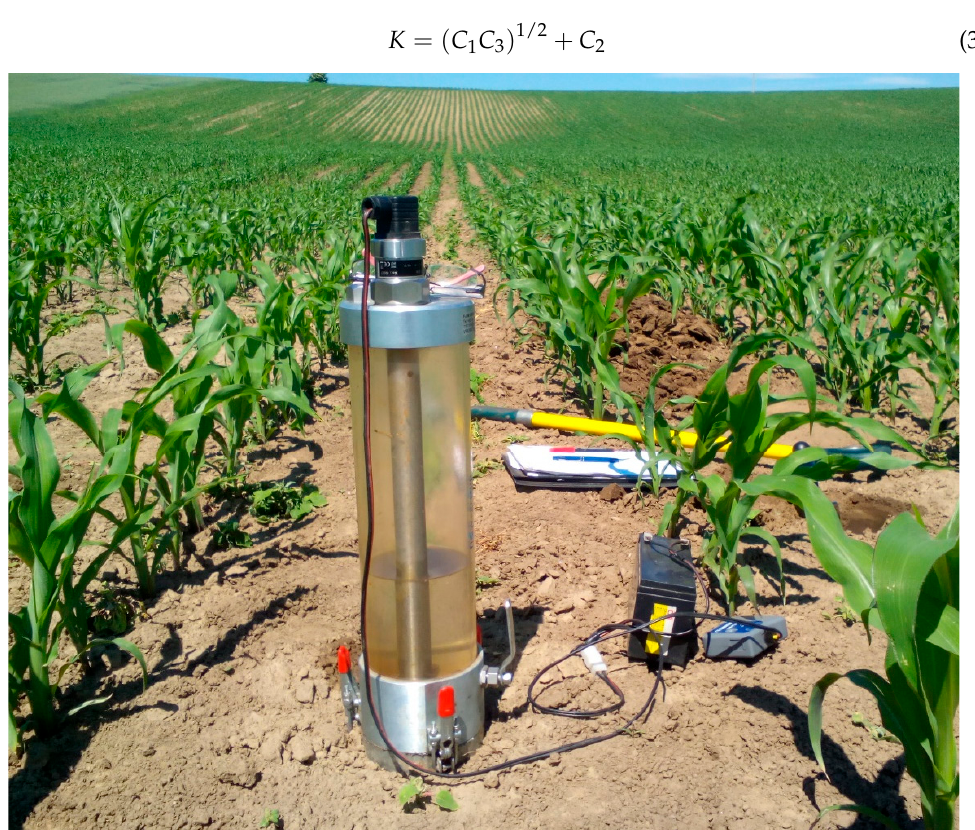
Figure 3. Ponding infiltrometer Flowgroup.